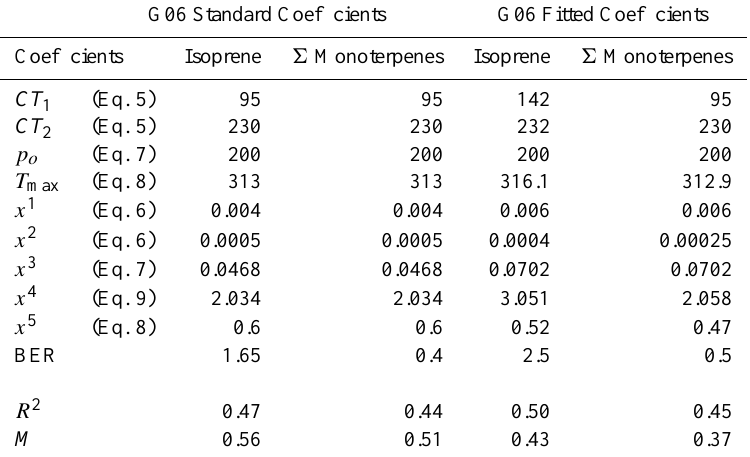
Table 4. Summary of the coefficients used to drive the MEGAN model. Standard coefficients are based upon studies of temperate plant species, whereas fitted coefficients relate to the measured flux data obtained during OP3-III over a tropical